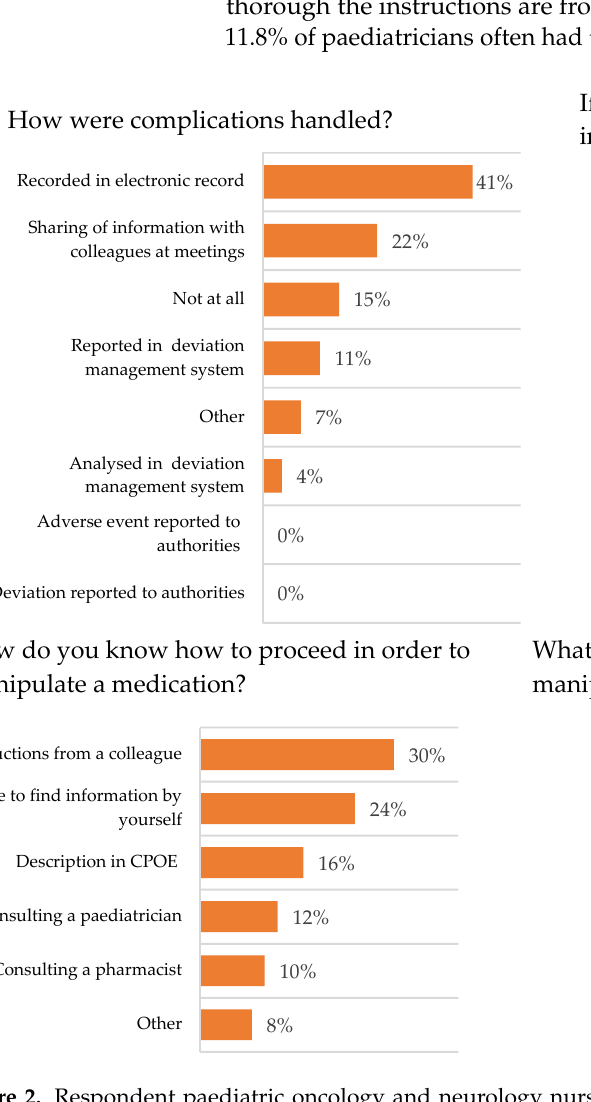
Figure 2. Respondent paediatric oncology and neurology nurses’ experiences and attitudes, N (%). Multiple choices possible. ( a ) n = 27, ( b ) n = 47, ( c ) n = 50 and ( d ) n = 27. CPOE = computerized physician order entry software.